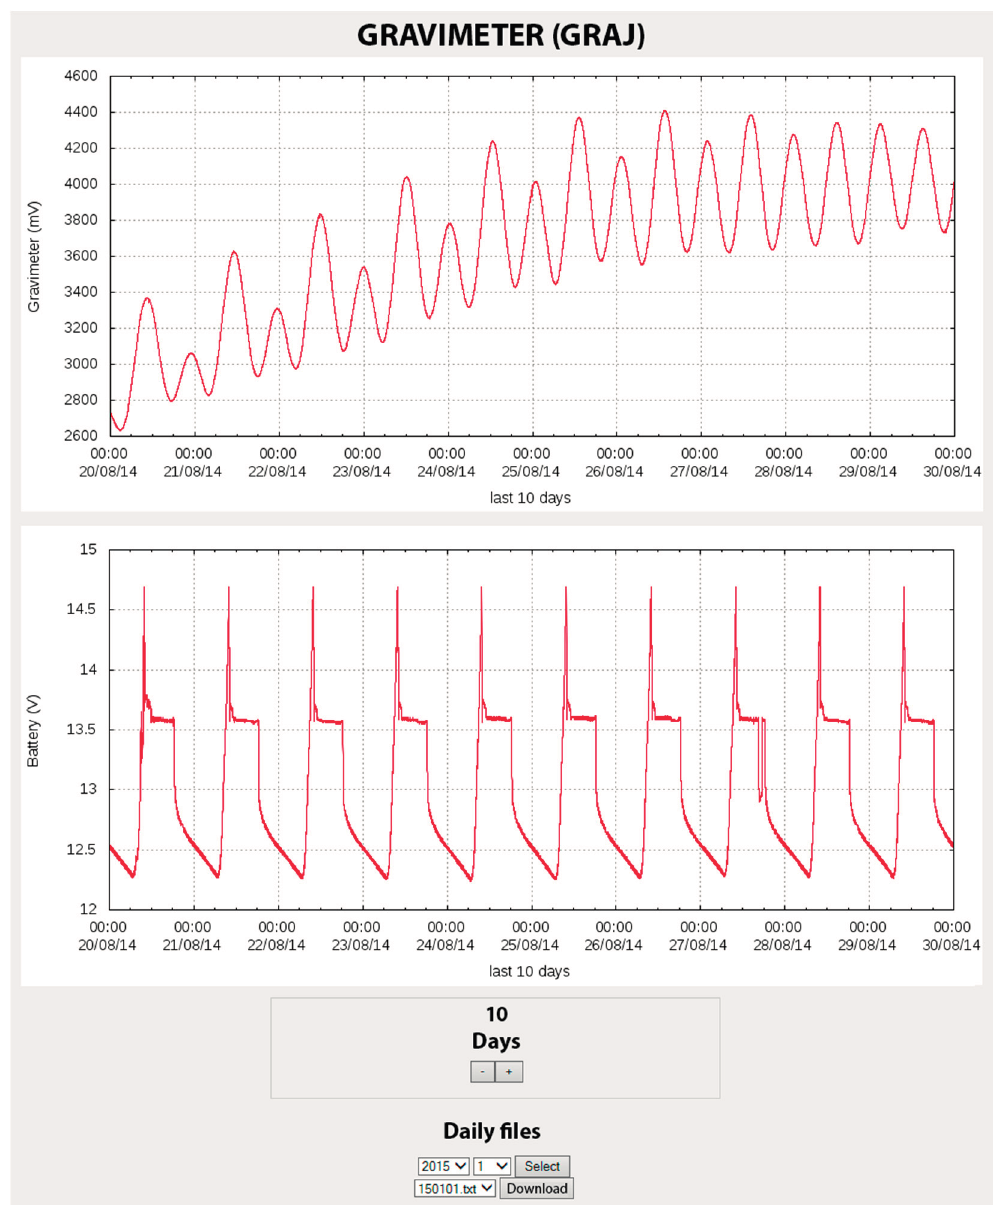
Figure 3. Image captured from the website corresponding to gravimeter measurements and battery control with the units of the depicted parameters in mV and V, respectively. A 10-day period is